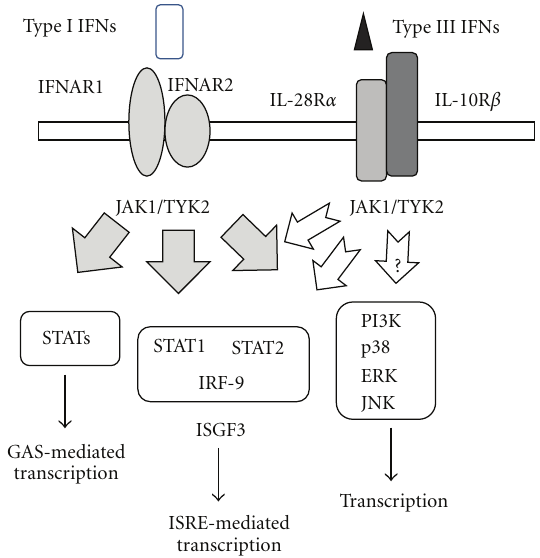
Figure 1: Signaling pathways mediated by type I and type III IFNs. Type I IFNs binding to the receptor complex induces JAK1 and TYK2 activation and phosphorylation of STAT1 and STAT2. The phosphorylated STAT1/STAT2 complex with IRF-9 forms ISGF3, which binds ISRE and initiates a number of transcriptions. Type I IFNs also activate STATs without forming ISGF3 and transactivate IFN-inducible genes through GAS elements. Additionally, type I IFNs activate the PI3K and p38 pathways to stimulate transcription of relevant genes through a number of transcription factors such as AP-1. Similarly, type III IFNs induce the JAK-STATs pathways; however, it is currently unknown whether type III IFNs activate the PI3K and p38